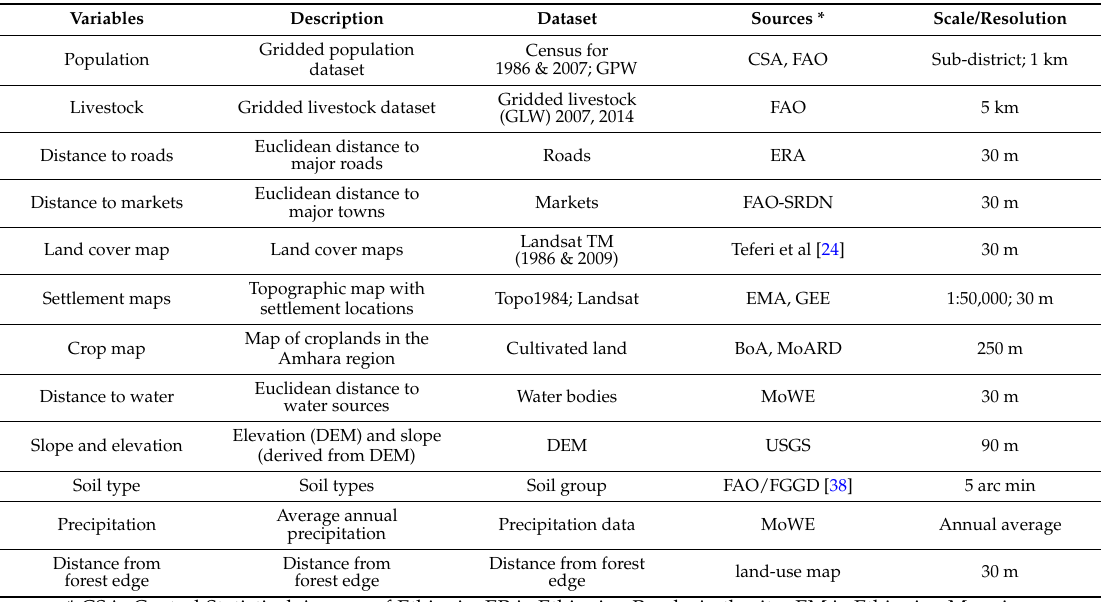
Table 1. Data inputs and potential land use change